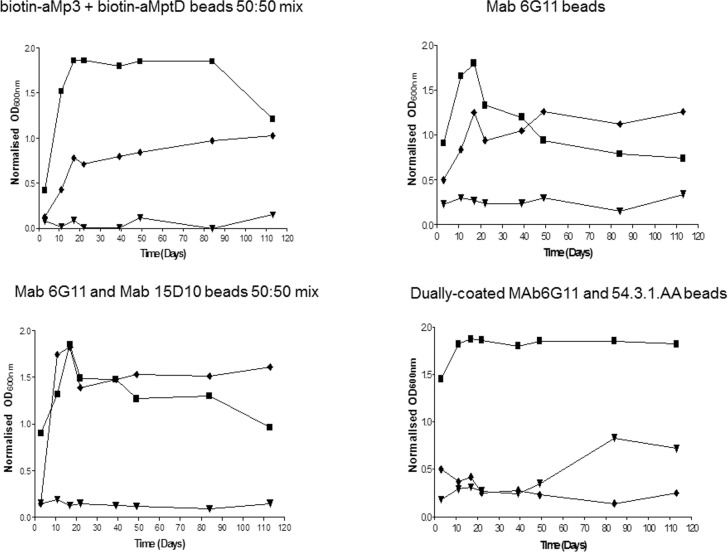
Outgrowth of milk bacteria non-specifically adhering to four types of coated magnetic beads in Middlebrook 7H9 OADC broth without (■) and with antibiotic supplements (NOA ◆ and PANTA ▼) after MS was applied to raw milk.